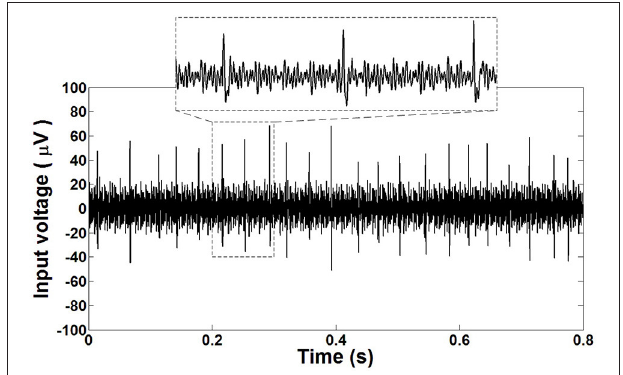
FIGURE 20 | Recorded extracellular APs extracted from the brainstem of a mouse with the fabricated neural